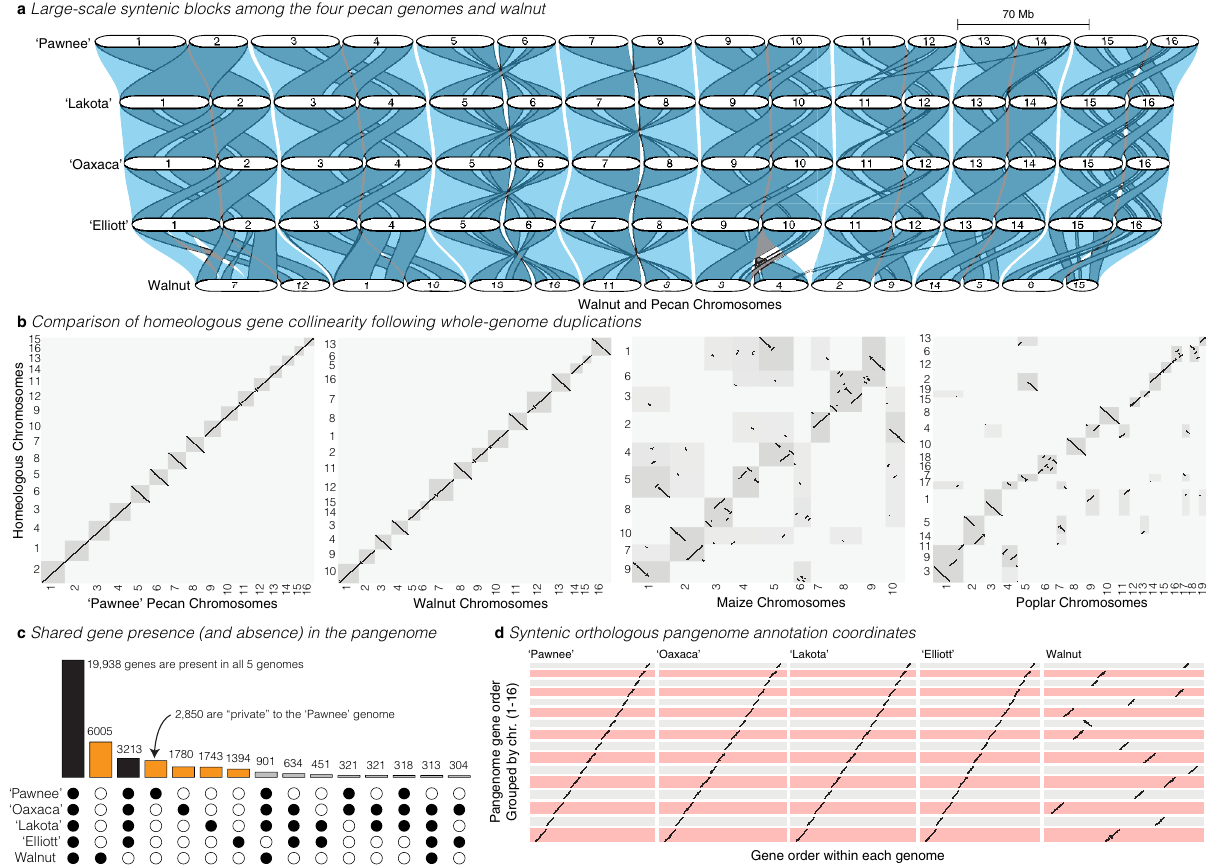
Fig. 1 Comparative analysis of four de novo pecan genomes. a A map of syntenic orthologous (transparent blue) and homeologous blocks (gray with black borders) among the four reference genomes and the walnut outgroup. Chromosomes are represented by white segments and are scaled to the same physical size (Mb: megabases) for all genomes. Orthologous chromosomes are stacked vertically and labeled accordingly. b Comparisons of the degree of synteny between homeologous chromosomes across the ‘ Pawnee ’ , walnut, maize, and poplar genomes. The dotplots display the gene-rank-order positions of syntenic blastp hits along the main genome ( x axis) and homoeologous chromosomes ( y axis). Chromosomal bounds are shaded by the total number of blast hits found between each pair of homeologous chromosomes. c Across the pan-genome, the vast majority of all genes are found in orthogroups that contain all four pecan genomes (bars shaded black); however, genes private to each genome (shaded orange) and, to a lesser degree, shared among >1 genome (gray) are also common. Filled circles represent presences in orthogroups; open circles are absences. d The high level of synteny between the pecan genomes and walnut allowed for simple pan-genome construction and gene ordering. Here, each point represents the location of a gene by its rank- order location within each de novo genome assembly ( x axis) and the inferred syntenic position in the pan-genome ( y axis). Source data are provided as a Source Data fi